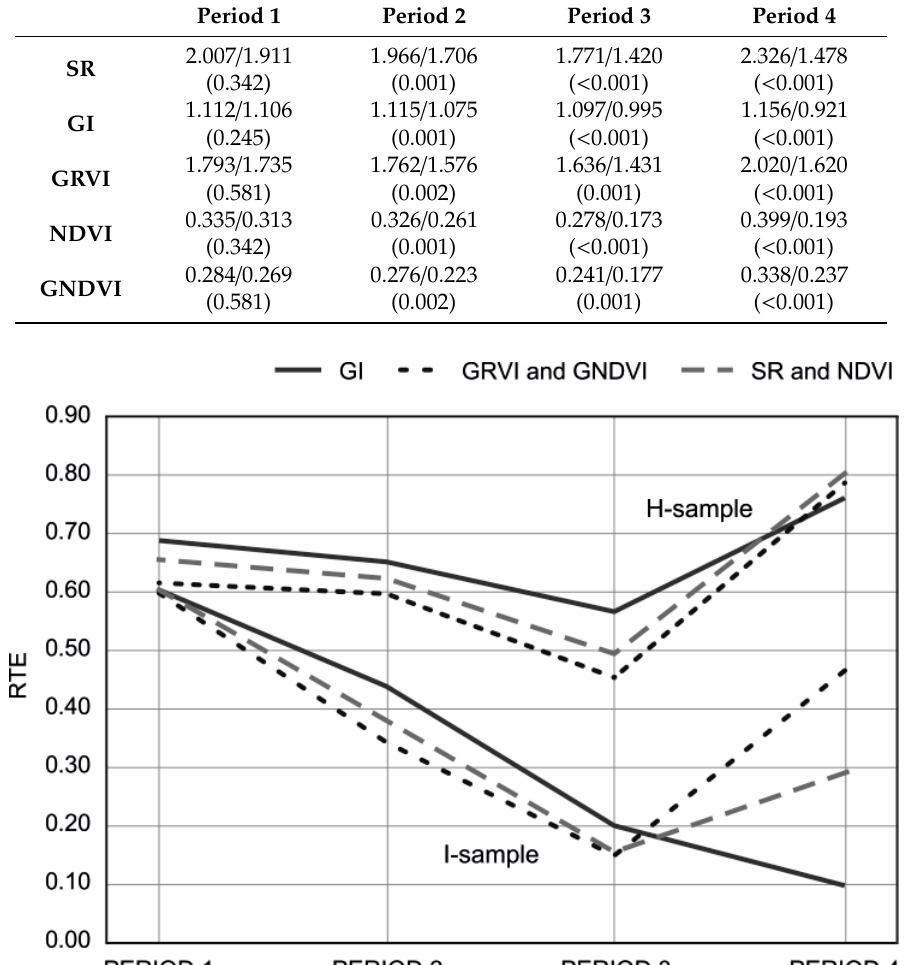
Figure 4. Relative Treatment Effect (RTE) values (GI: solid curves, GRVI and GNDVI: dotted curves, SR and NDVI: dashed curves; H-sample—upper curves, I-sample—lower curves).